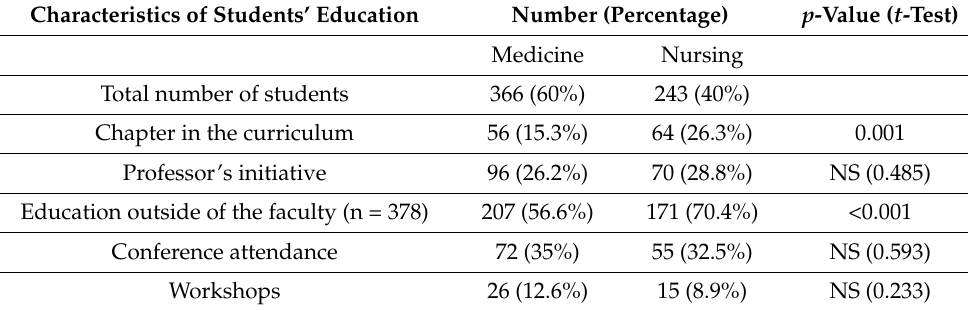
Table 3. Characteristics of students’ education ( n =